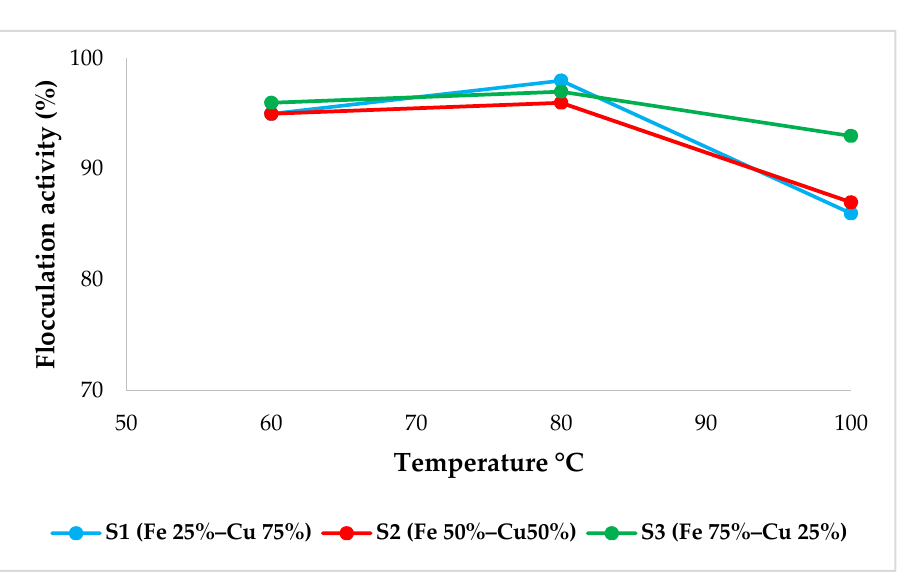
Figure 6. E ff ect of temperature on flocculation process of samples S1, S2, and Figure 6. Effect of temperature on flocculation process of samples S1, S2, and S3.